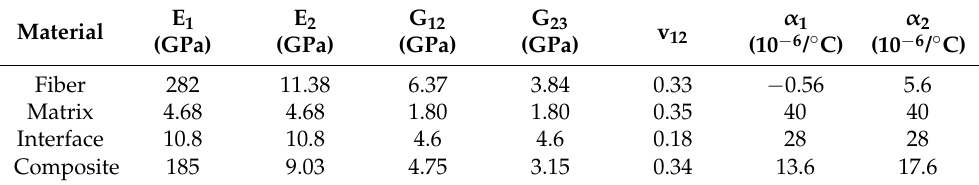
Table 1. Thermo-elastic constants of the matrix, fibers, and the homogenized composite.